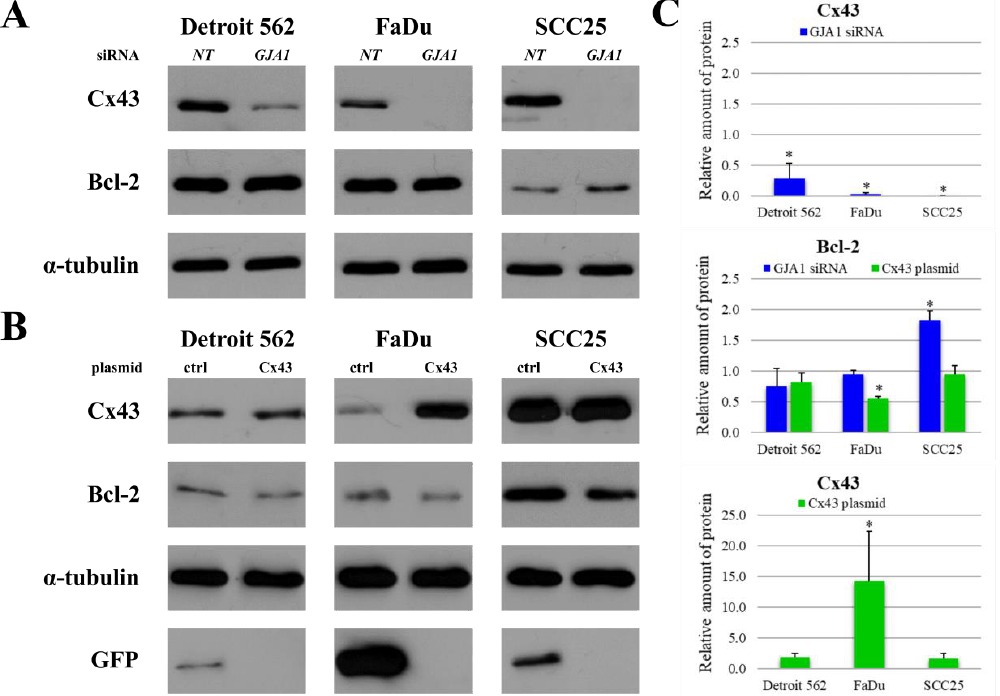
Figure 4. Changes in the levels of Cx43 and Bcl-2 after GJA1 (gap junction protein alpha-1)